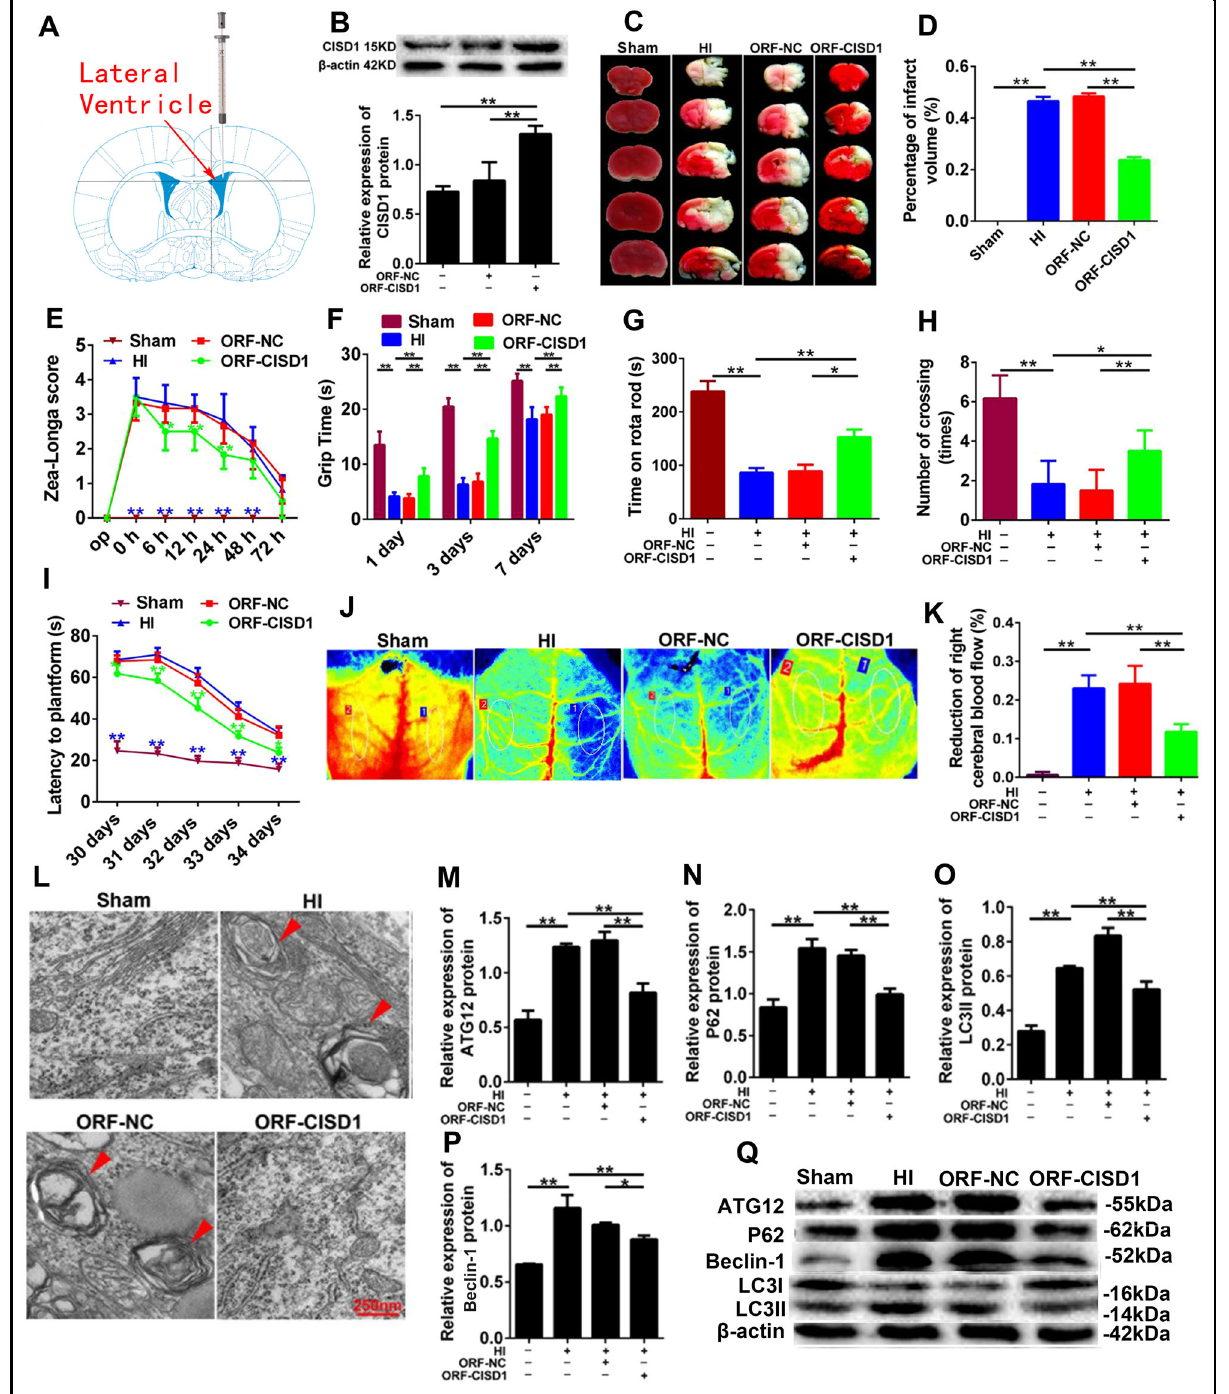
Fig. 8 The role of CISD1 overexpression in autophagy and neurological impairment in vivo. A The ideograph of ORF- CISD1 lentivirus injection site. B The protein expression of CISD1 increased after injection of ORF- CISD1 lentivirus. C TTC staining of rat brains. Scale bar = 1cm. D Infarcts were quanti fi ed by planimetry and expressed as a percentage of risk zones. E Zea-longa score of HI rats. F Grip times were assessed in 1d, 3d, and 7d after HI. G Time on rotarod was assessed in 38d after HI. H Number of crossing was recorded in 38d after HI. I Latency to platforms were assessed in 30d, 31d, 32d, 33d, and 34d after HI. J , K Reduction of right cerebral blood fl ow after HI. L Representative EM images of autophagic vacuoles were shown. Scale bar = 250nm. The arrows depict autophagosomes. M – Q The expression of ATG12, P62, Beclin-1 LC3I, and LC3II were detected by western blotting. Representative immunoblot for conversion of LC3I to LC3II in Sham group, HI group, ORF-NC group and ORF- CISD1 group. The densitometric analysis of WB of LC3II is shown. Data are shown as mean±s.d. * P <0.05, ** P <0.01 with one-way ANOVA, n = 6. CISD1 CDGSH iron-sulfur domain-containing protein 1, HI hypoxia ischemia, ORF-NC negative control overexpression, ORF CISD1 CISD1 overexpression, H hours, S